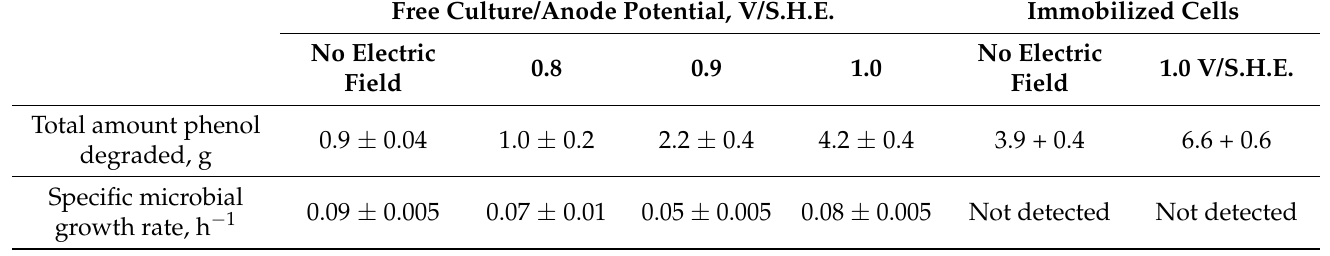
Table 1. Total amounts of degraded phenol and specific bacterial growth rates during the experiments. Initial phenol concentration, 0.06 g dm − 3 .